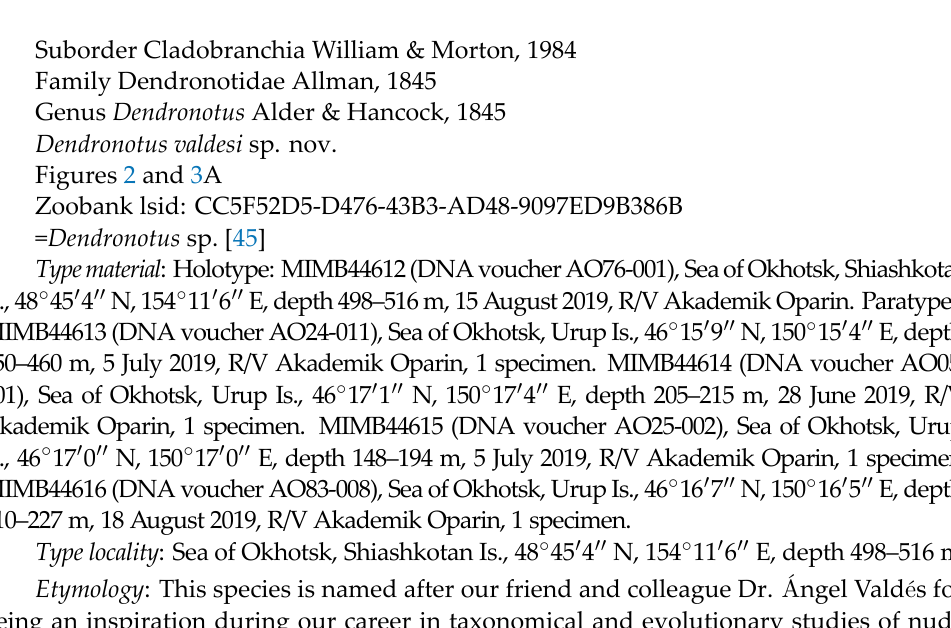
Color (Figure 2A–C): Background color from milky‑white to yellowish or light pink. Large, light‑brown or light‑pinkish patches on dorsal and upper lateral parts of body, with breaks by dorsal midline, and small brown patches in upper parts of foot. Pigmental patches of intensive brown color form traceried aggregations in dorsolateral spaces be‑ tween appendages. Dorsal side, appendages, rhinophores, and upper parts of foot are covered by fine irregular silver